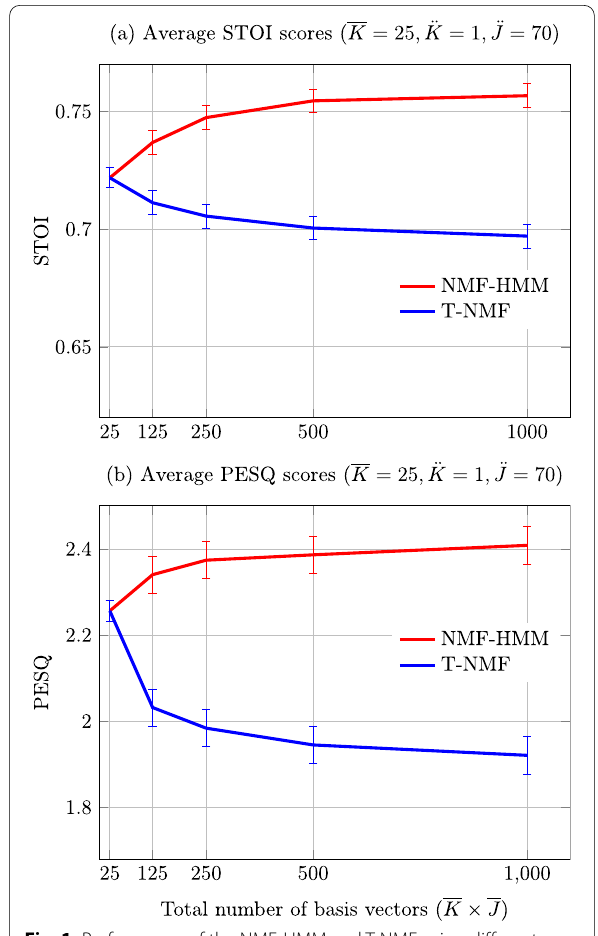
Fig. 1 Performance of the NMF-HMM and T-NMF using different numbers of clean speech basis vectors